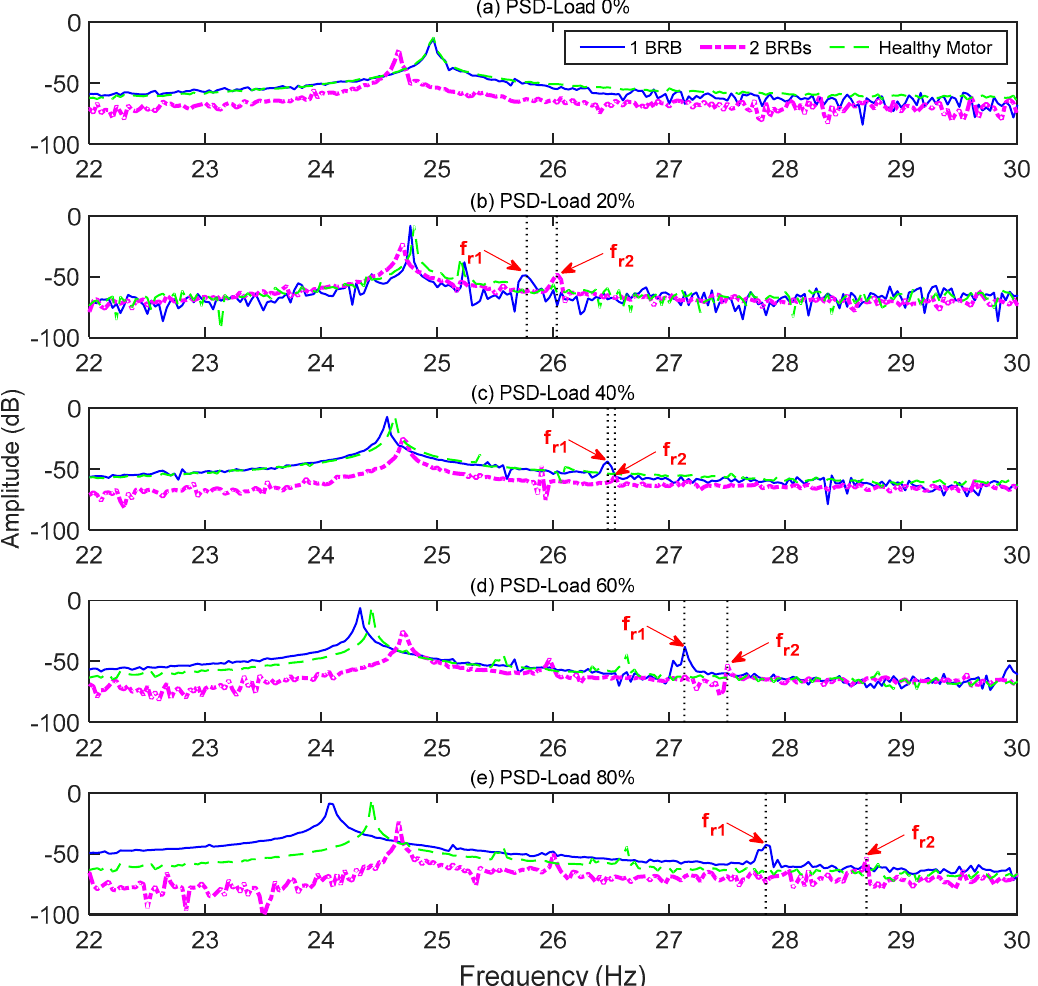
Figure 7. The right sideband components f r 1 and f r 2 for 1 BRB and 2 BRBs based on the power spectral density (PSD) method at ( a ) 0% load, ( b ) 20% load, ( c ) 40% load, ( d ) 60% load, and ( e ) 80% load under operating conditions. Blue for 1 BRB, Pink for 2 BRBs, and Green under healthy motor. Table 5. The slips and characteristic frequencies of three fault cases under different loads.